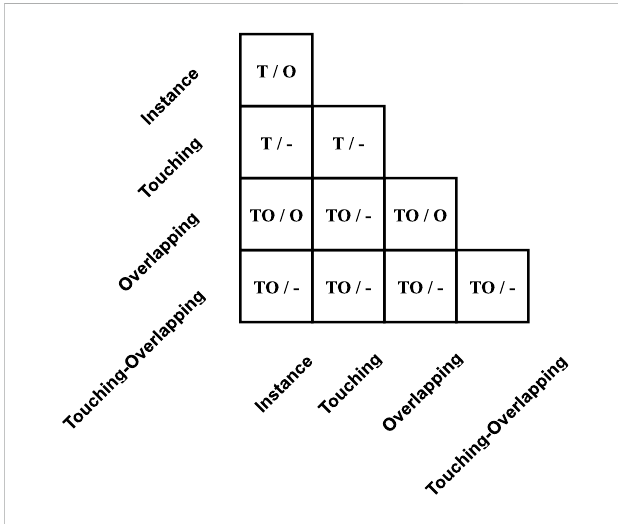
FIGURE 5 Detailof y g inthe middle -Table.Theleftsignsineachcellrepresent assigned labels when the number of pixel intersections of warped I p and I c is below or equal to the pixel intersection threshold P ∩ , and the right side signs represent assigned labels when pixel intersections are larger than the threshold. Furthermore, mark ’ T ’ , ’ O ’ , ’ TO ’ , and ’ - ’ represent touching, overlapping, touching-overlapping, and uncertainty tags, respectively.